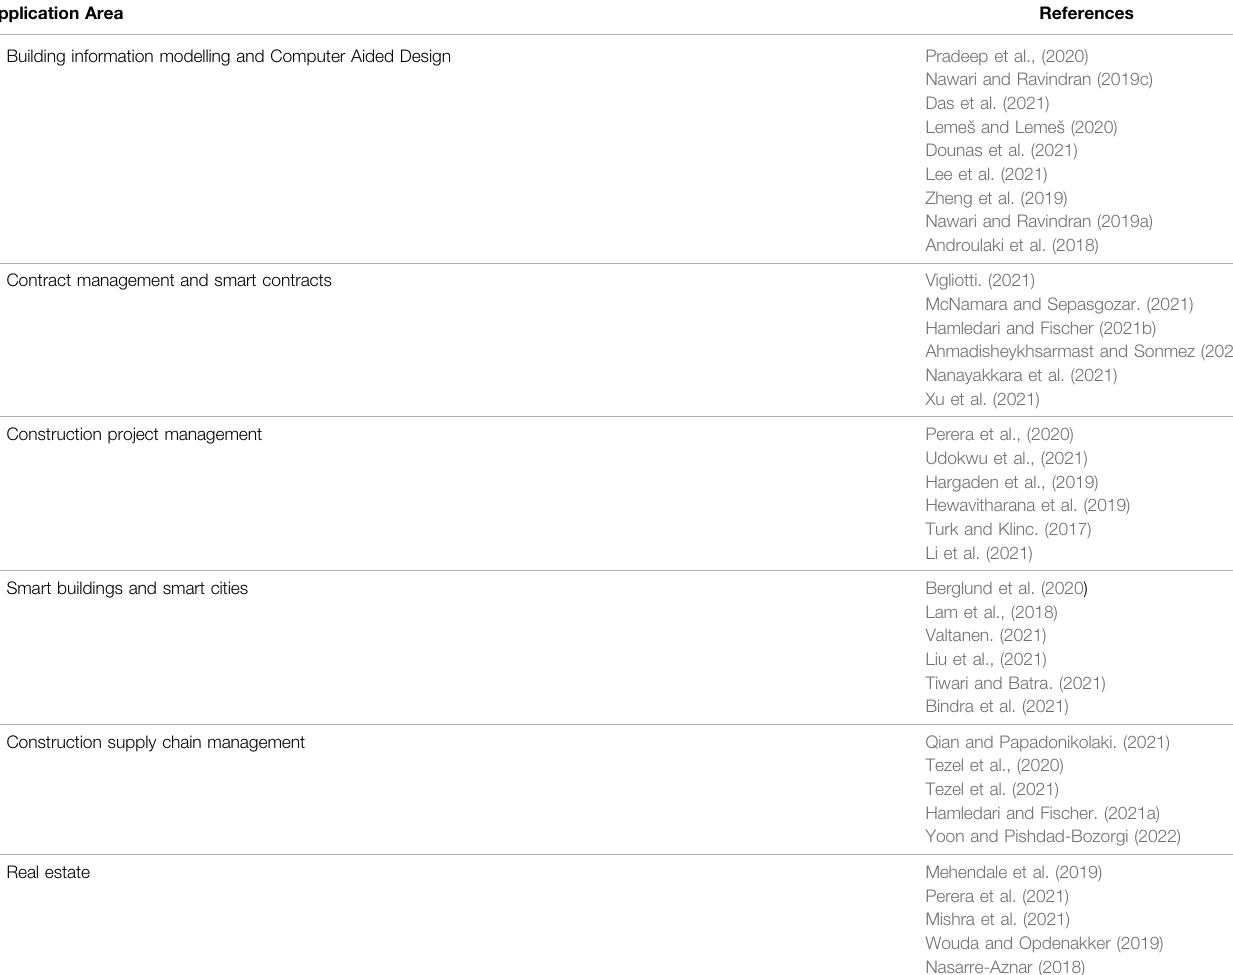
TABLE 3 | Key areas of the civil, architectural and construction industry where blockchain can be applied. Application